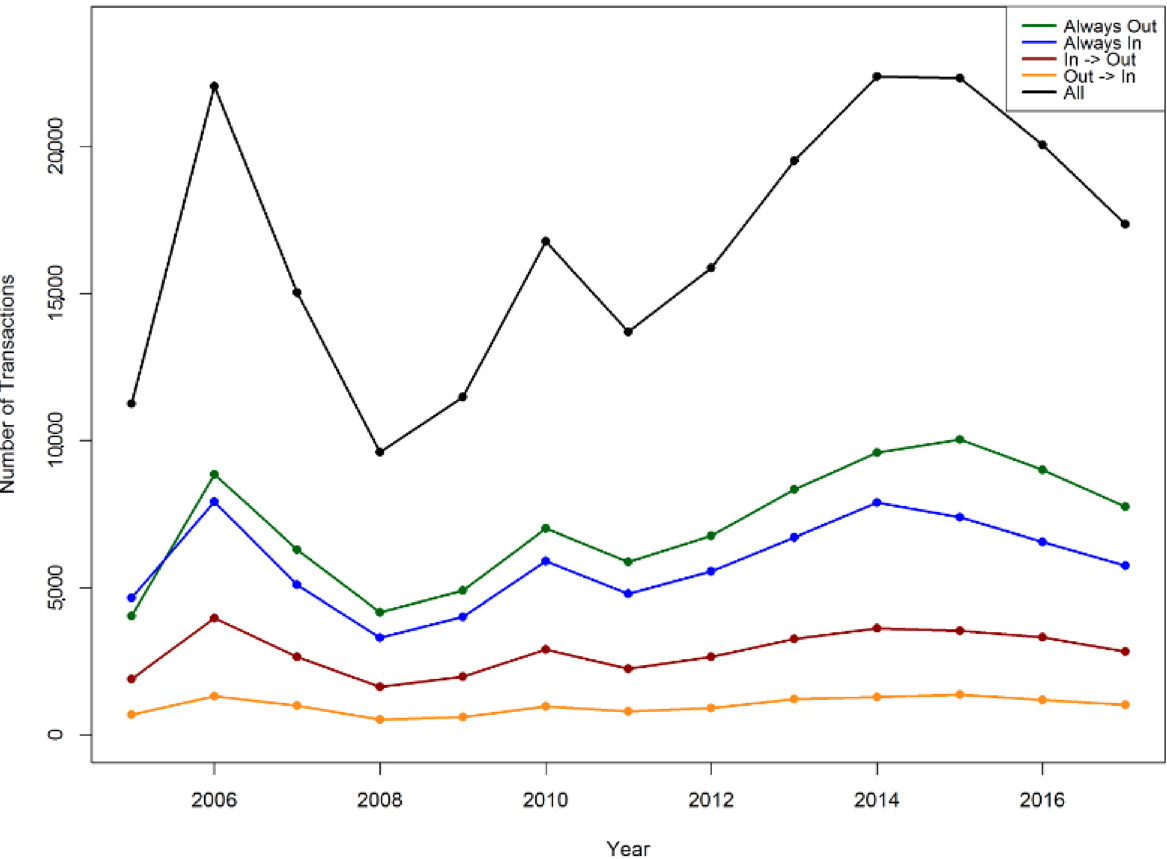
Figure 2. Temporal trend in transaction history by flood zone change category, 2005–2011.